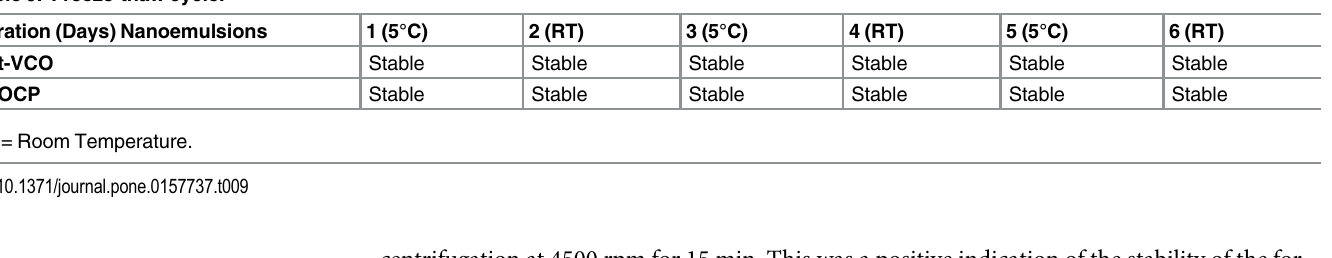
centrifugation at 4500 rpm for 15 min. This was a positive indication of the stability of the for- mulations, if phase separation occurs; all the physical and chemical properties of the formula- tions will be affected. For the freeze-thaw cycling test; Opt-VCO and VCOCP were found to be stable (homoge- nous) after 6 days as depicted in Table 9. When the samples freeze, the oil droplets can be segre- gated from the emulsion by the crystallized ice particles and this leads to the disruption of the lipid film surrounding the droplets. These droplets can be melted and coalesced between approaching droplets when subjected to thaw leading to phase separation. All the formulations were observed to be in one phase even when temperatures were drastically changed. The stability expected to be able to reduce both the re-association of oil droplets and formation of ice crystals. taining copper peptide (VCOCP) were investigated over 90 days of storage time and the results are as depicted in Fig 6. Particle size of VCOCP remained almost constant at 25°C but showed